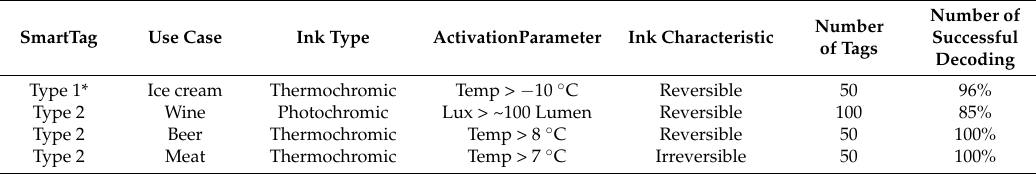
Table 1. SmartTag evaluation